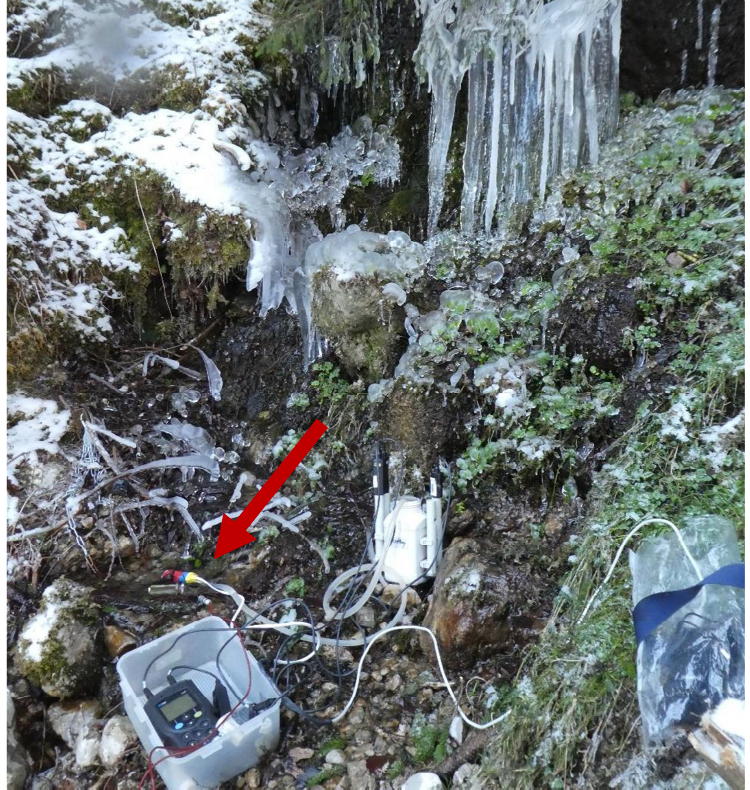
Figure 4. Application of a flow pump (marked by the red arrow) during winter low-discharge conditions in the field in the Berchtesgaden National Park to keep measuring sensors constantly covered with water.